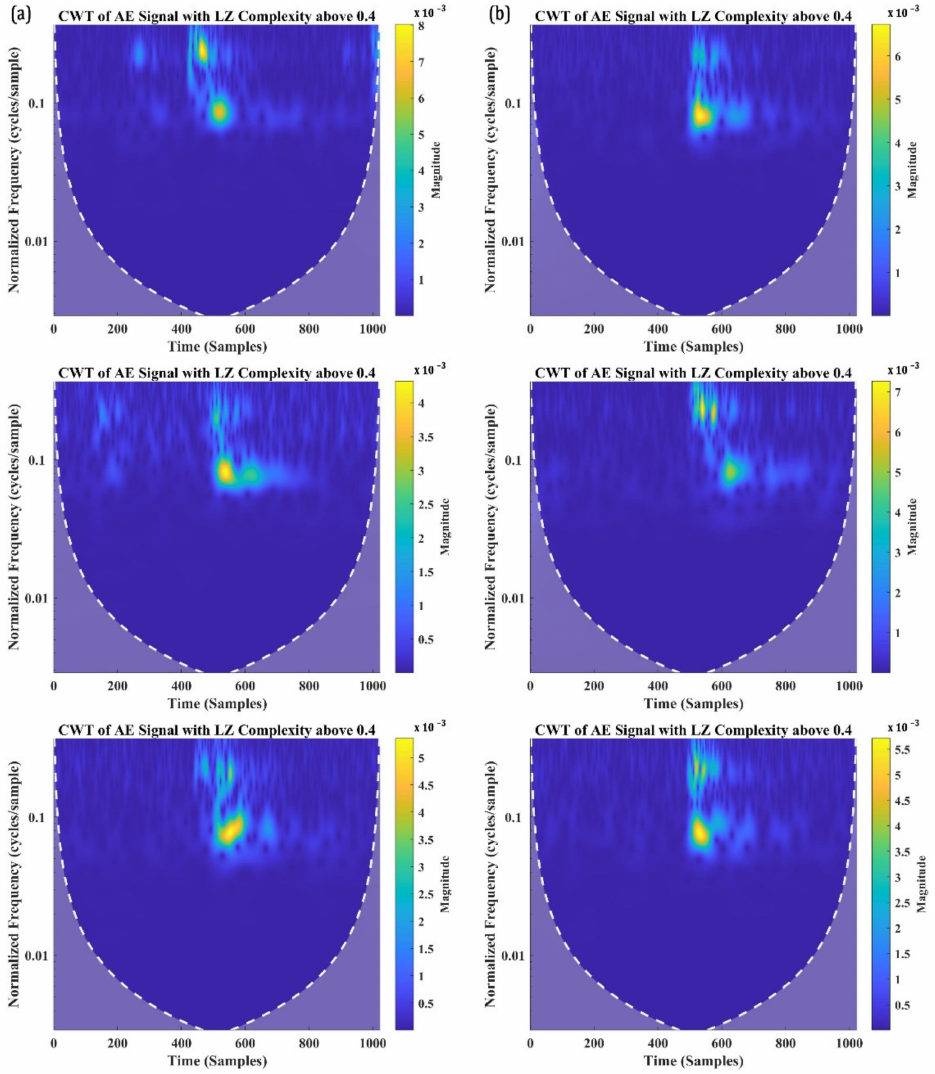
Figure 11. CWT of the AE signals with W.P-Freq between 200 kHz and 300 kHz and LZ complexity above 0.4 recorded from SBS specimens tested at ( a ) 100 ◦ C and ( b ) 120 ◦